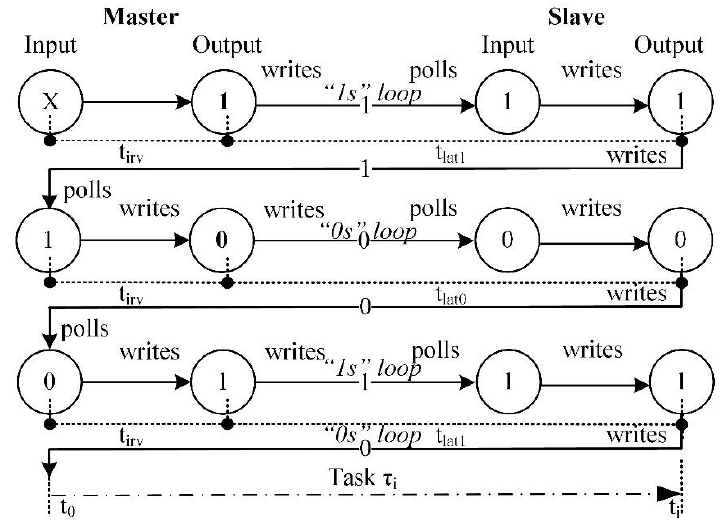
Figure 4. Master-slave inputs-outputs cycles of “1 s” and “0 s”.